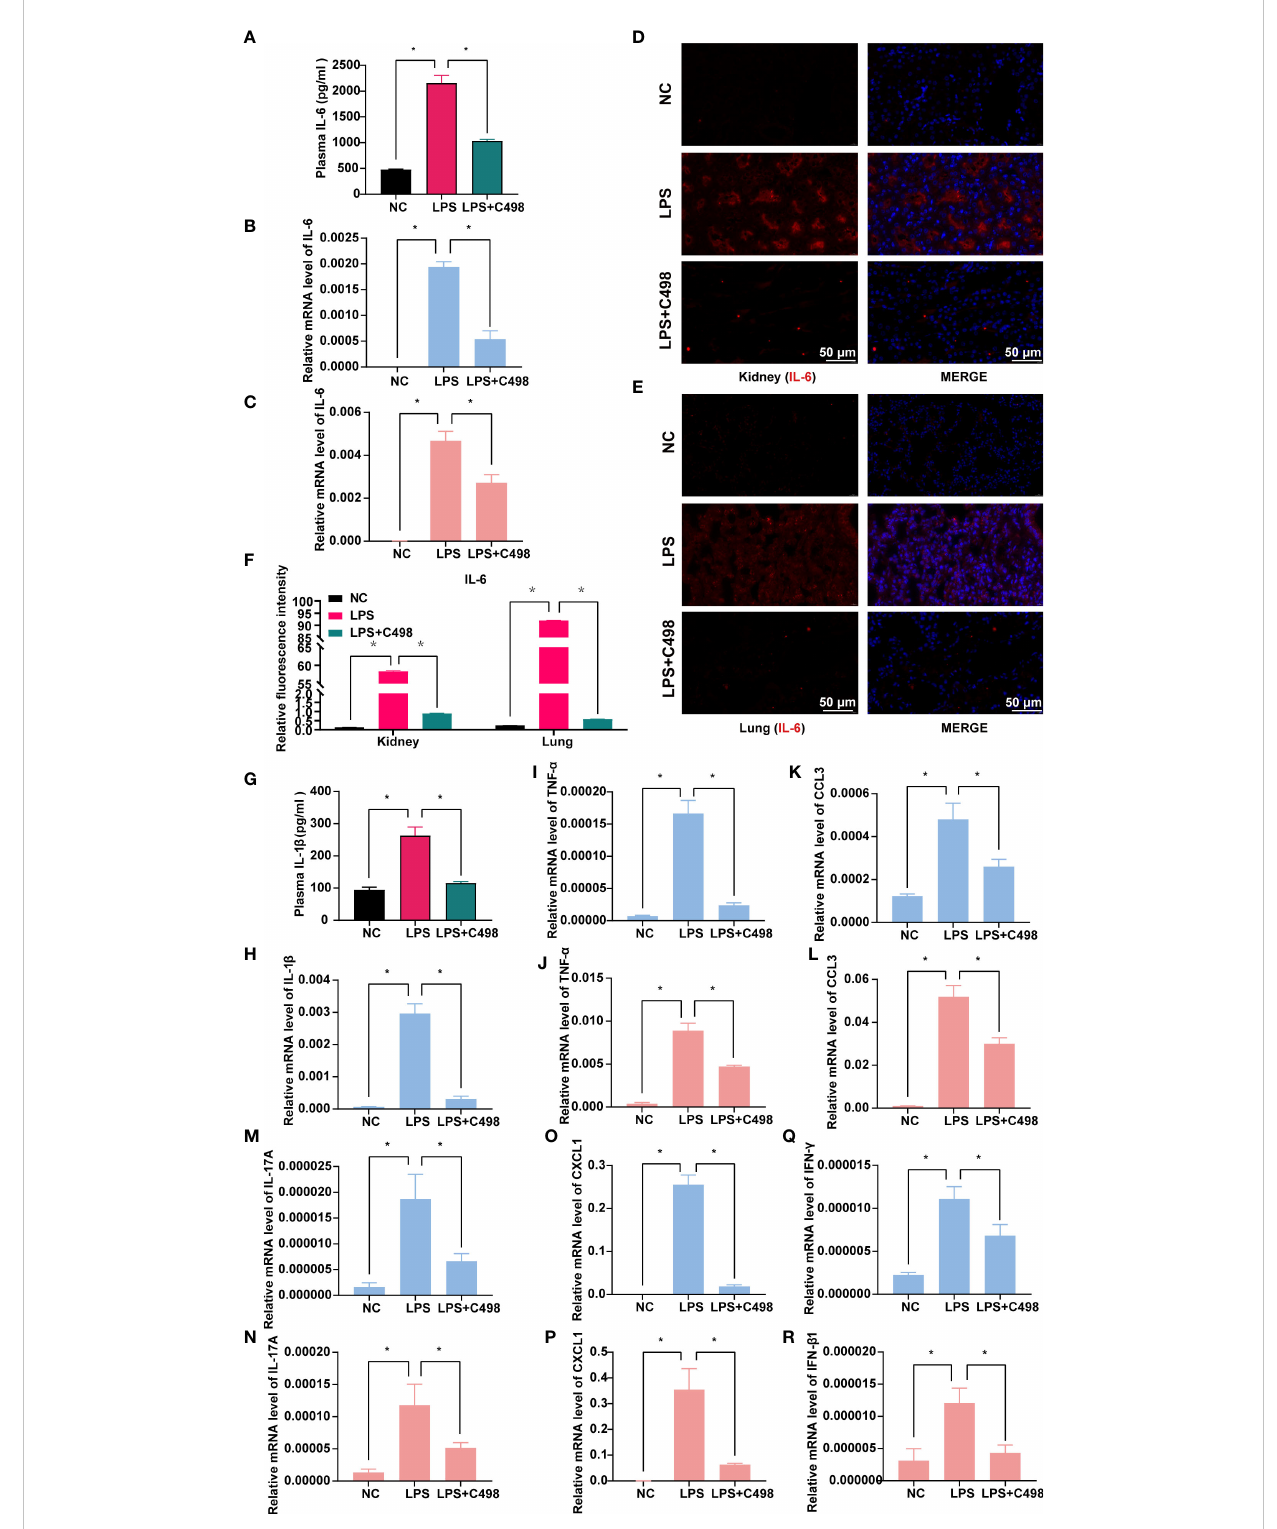
FIGURE 6 C498 inhibits the expression of relevant in fl ammatory factors in sepsis models. Mice were i.p. administrated with 5 mg/kg C498 12 h before the LPS challenge (6 mg/kg, i.p.) and sacri fi ced at 12h or 24h after LPS injection. The detection of 24 h plasma IL-6 levels by ELISA assay (A) . Mice treated as in (A) were sacri fi ced 12 h after LPS injection and the relative mRNA levels of IL-6 in kidney (B) and lung (C) were determined by RT- PCR. Immuno fl uorescence (D, E) and relative fl uorescence intensity (F) of kidney and lung (100 ×). Red color indicates IL-6 staining and blue indicates nuclear DAPI staining (D-F) . The detection of 12 h plasma IL-1 b levels (G) by ELISA assay and the relative mRNA levels of IL-1 b in kidney (H) by RT- PCR. The mRNA levels of TNF- a (I, J) , CCL3 (K, L) , IL-17A (M, N) , CXCL1 (O, P) , IFN- g (Q) , and IFN- b (R) within kidney (I, K, M, O, Q) and lung (J, L, N, P, R) tissues were determined by RT- PCR. *P < 0.05 is considered signi fi